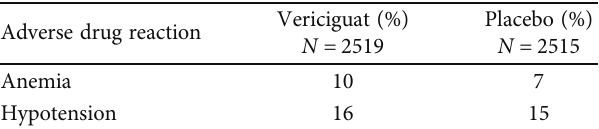
Table 2: Adverse drug reactions occurring with vericiguat in